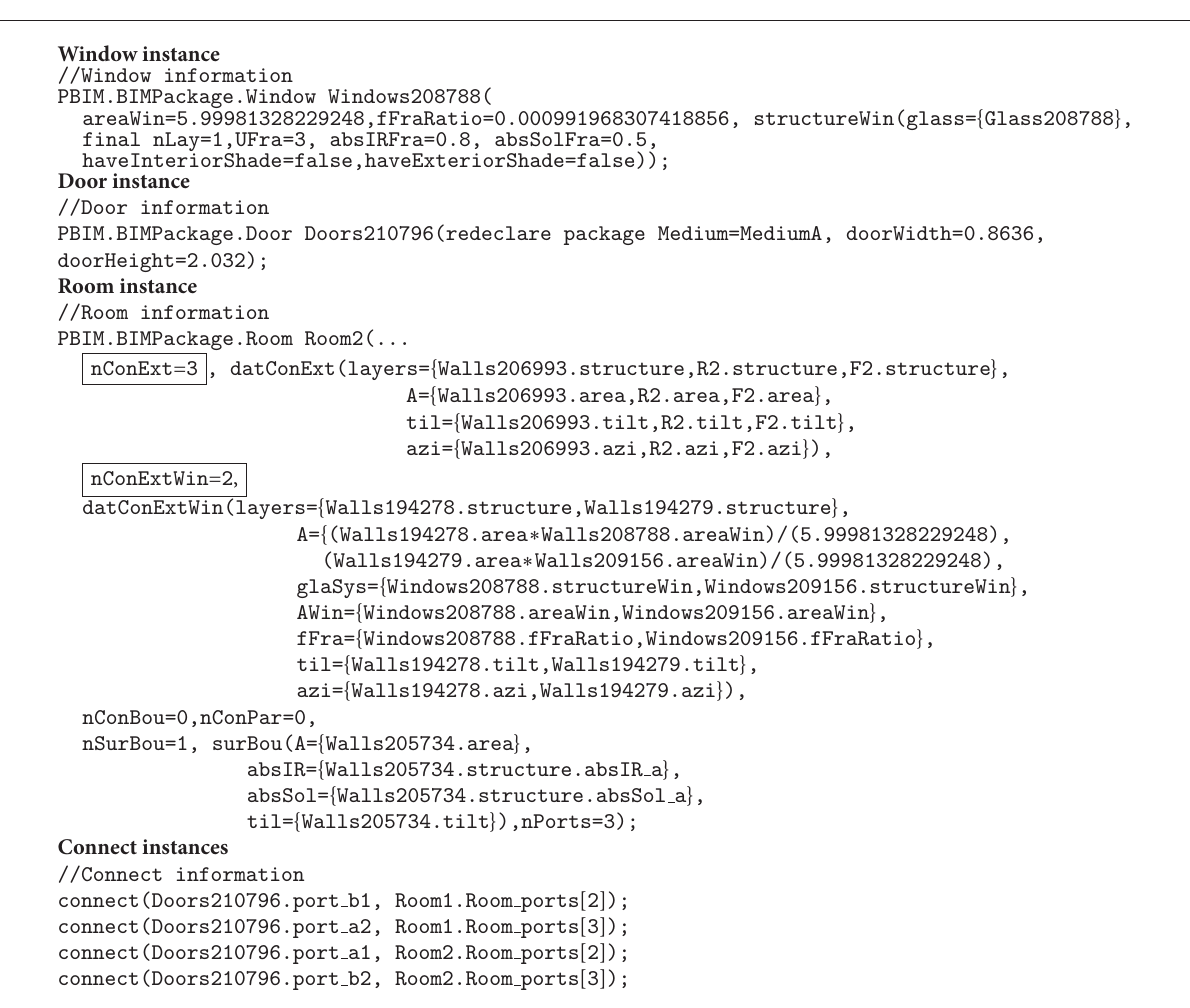
Figure 10: The window family in Revit, (a) a plan view and (b) an elevation